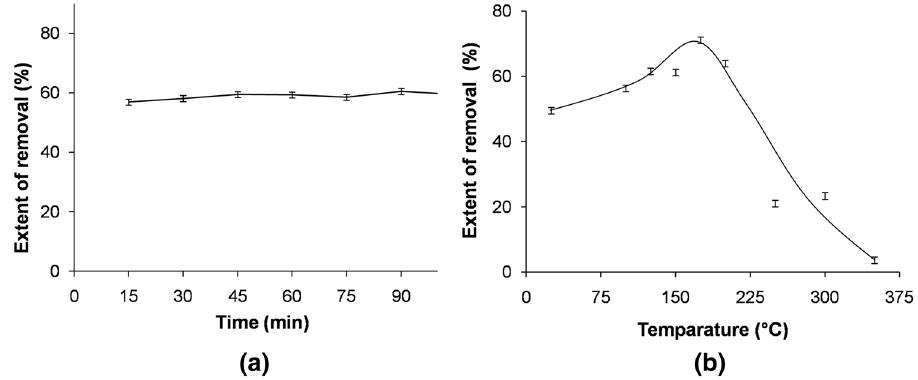
Fig. 3 Variation of extent of removal of Ni(II) at different pH